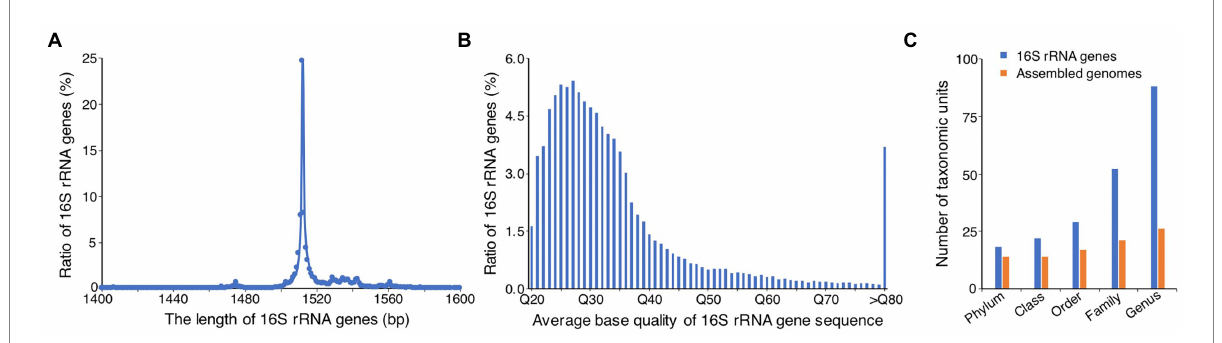
FIGURE 6 Analysis of microbial communities based on the full-length 16S rRNA genes identified from HiFi reads. (A) Distribution of the length of 16S rRNA genes. (B) Distribution of sequencing quality of 16S rRNA genes. Q20 means an average base accuracy of 99%, Q30 means 99.9%, and so on. (C) Comparison of the number of taxonomic units identified by genome taxonomy and full-length 16S rRNA genes at different taxonomic ranks.